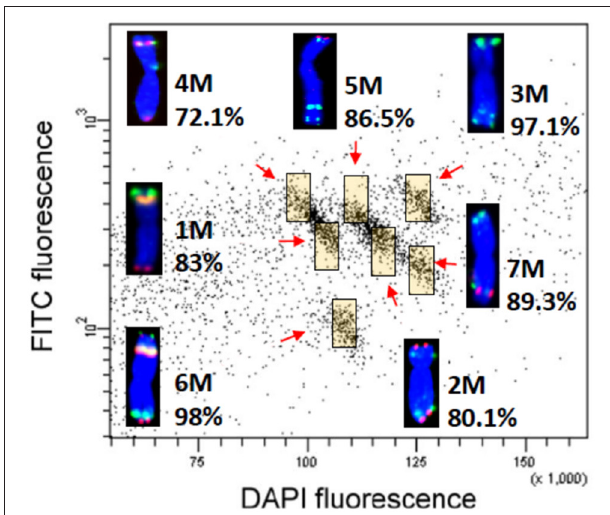
FIGURE 5 | Bivariate flow karyotyping of Ae. comosa chromosomes after fluorescence in situ hybridization in suspension (FISHIS) with probes for (GAA) 7 and (ACG) 5 resolved all seven M-genome chromosomes, which could be flow-sorted at purities of 72–98%. Chromosomes were assigned to the colored regions (yellow) by fluorescence in situ hybridization using probes for 45S rDNA (yellow), Afa family (green), and pSc119.2 (red). Chromosomes were counterstained by DAPI